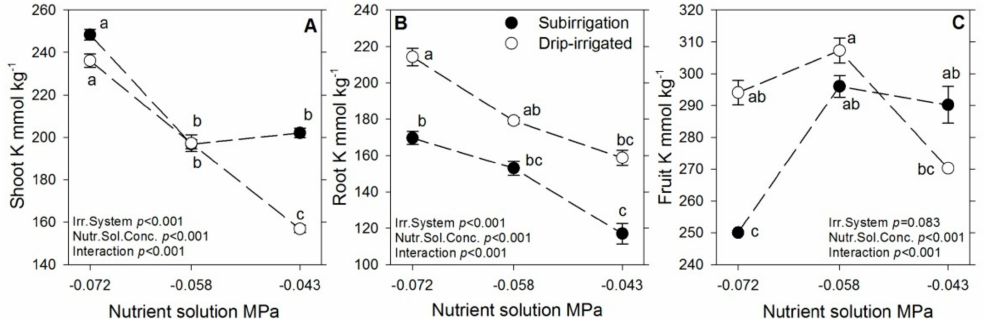
Figure 6. ( A – C ) Effect of the irrigation system and the concentration of the nutrient solution on potassium concentration in tomato ( Solanum lycopersicum L.) plants. ANOVA significance for both factors, irrigation system (Irr. System) and nutrient solution concentration (Nutr. Sol. Conc.), and the interaction is shown. Means with the same lower-case letter indicate non-significant differences according to Tukey’s multiple comparison test. Bars represent the standard error of the mean ( n = 4).